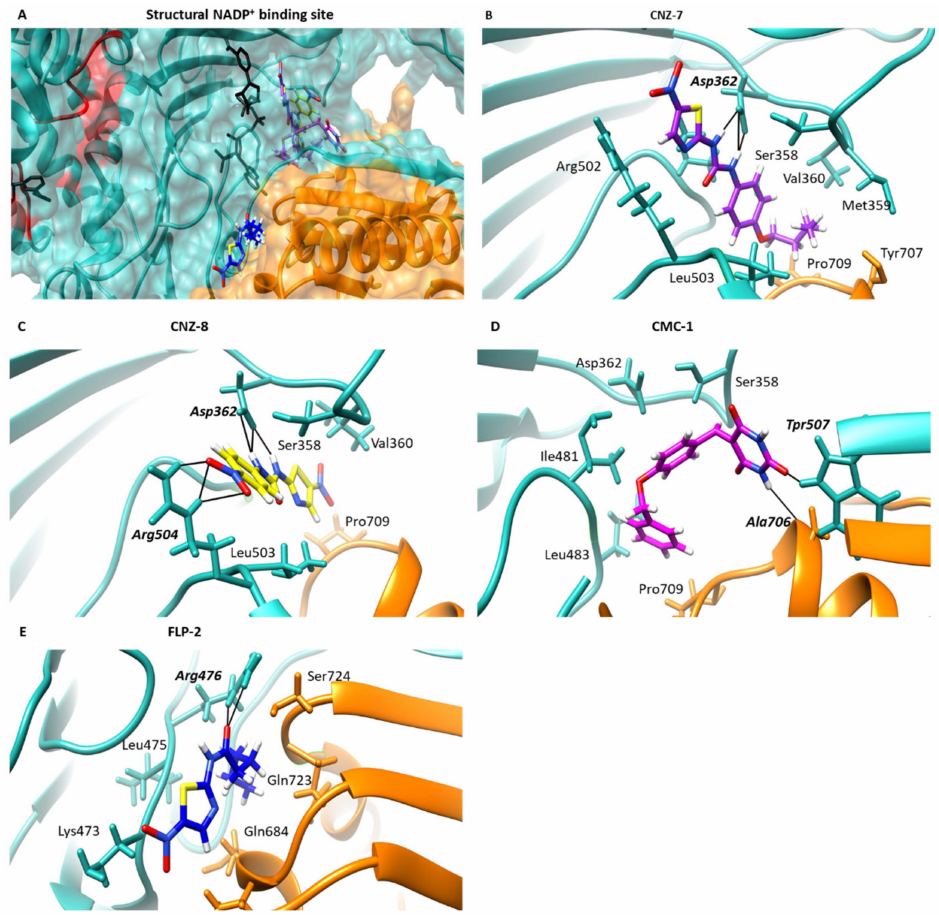
Figure 8. Molecular docking of the compounds on the G6PD::6PGL model. ( A ) General view of the predicted binding poses of CNZ-7 (purple), CNZ-8 (blue), CMC-1 (pink), and FLP-2 (blue) in the binding pocket of the structural NADP + binding site. The NADP + is shown in red color. ( B ) Closer view of the binding interactions of CNZ-7, ( C ) CNZ-8, ( D ) CMC-1, and ( E ) FLP-2. H-bonds are represented as black lines, and the amino acid residues are shown in bold and italic